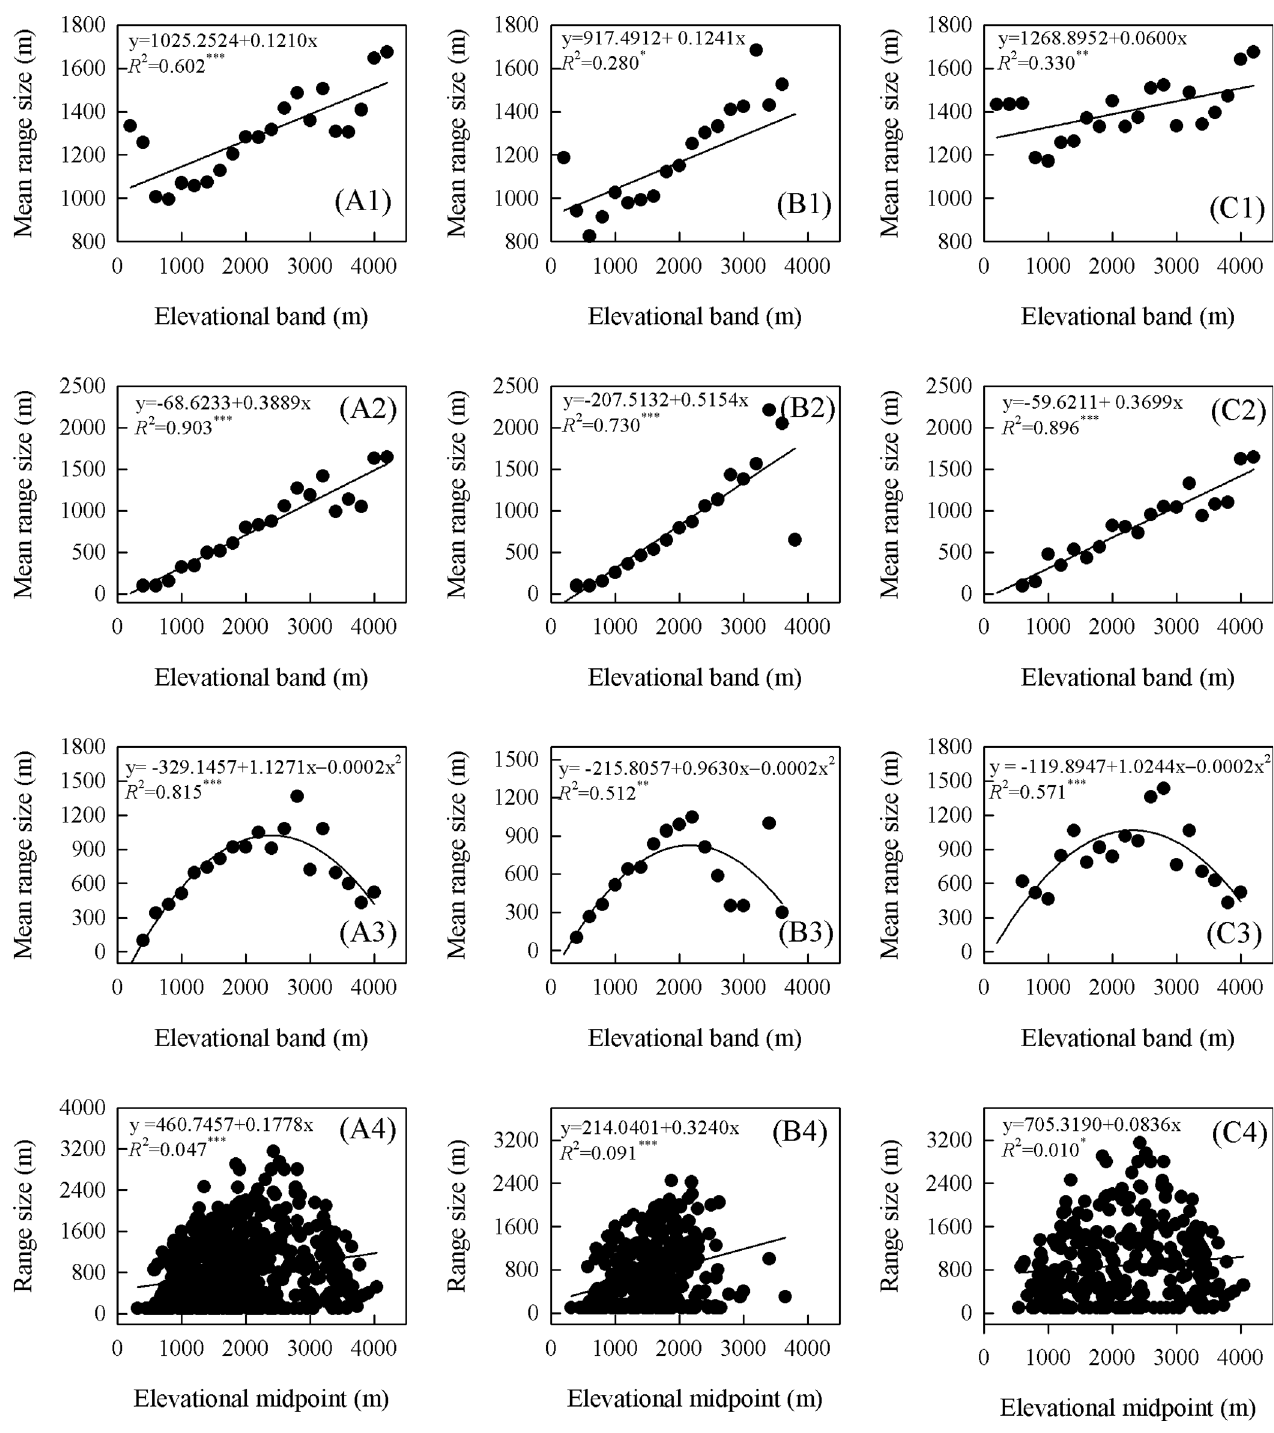
Fig 10. Elevation-related patterns of range size for all species (A), and for epiphyte (B) and terrestrial (C) forms. Suffixes in each panel indicate analytical method: 1, Stevens; 2, Pagel; 3, Mid-Point; and 4, Cross-Species.